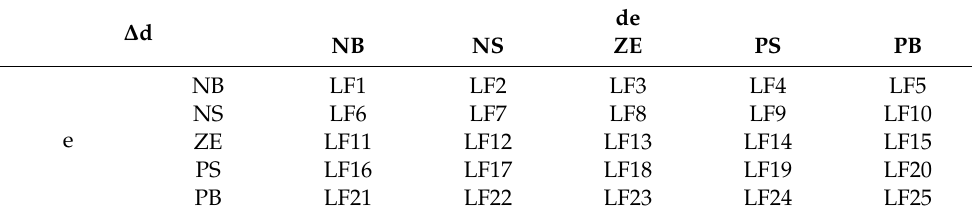
Table 1. Fuzzy rules of proposed hybrid control